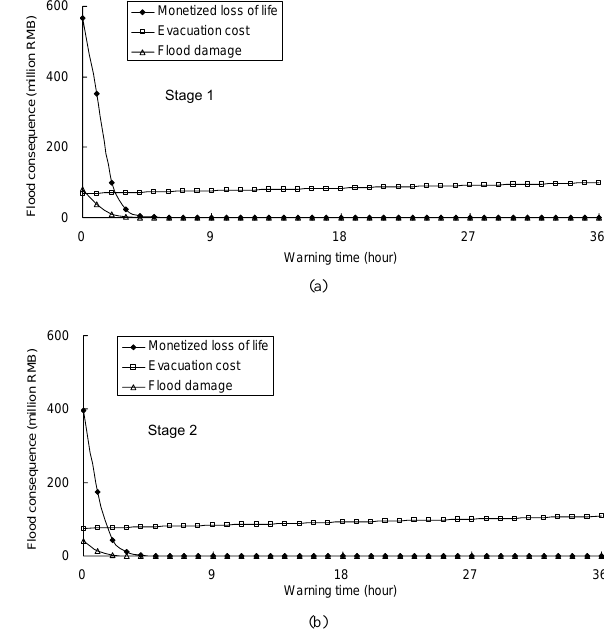
Fig. 14. Flood consequences in Mianyang City: (a) stage 1; (b) stage 2. No flooding is predicted in stage 3